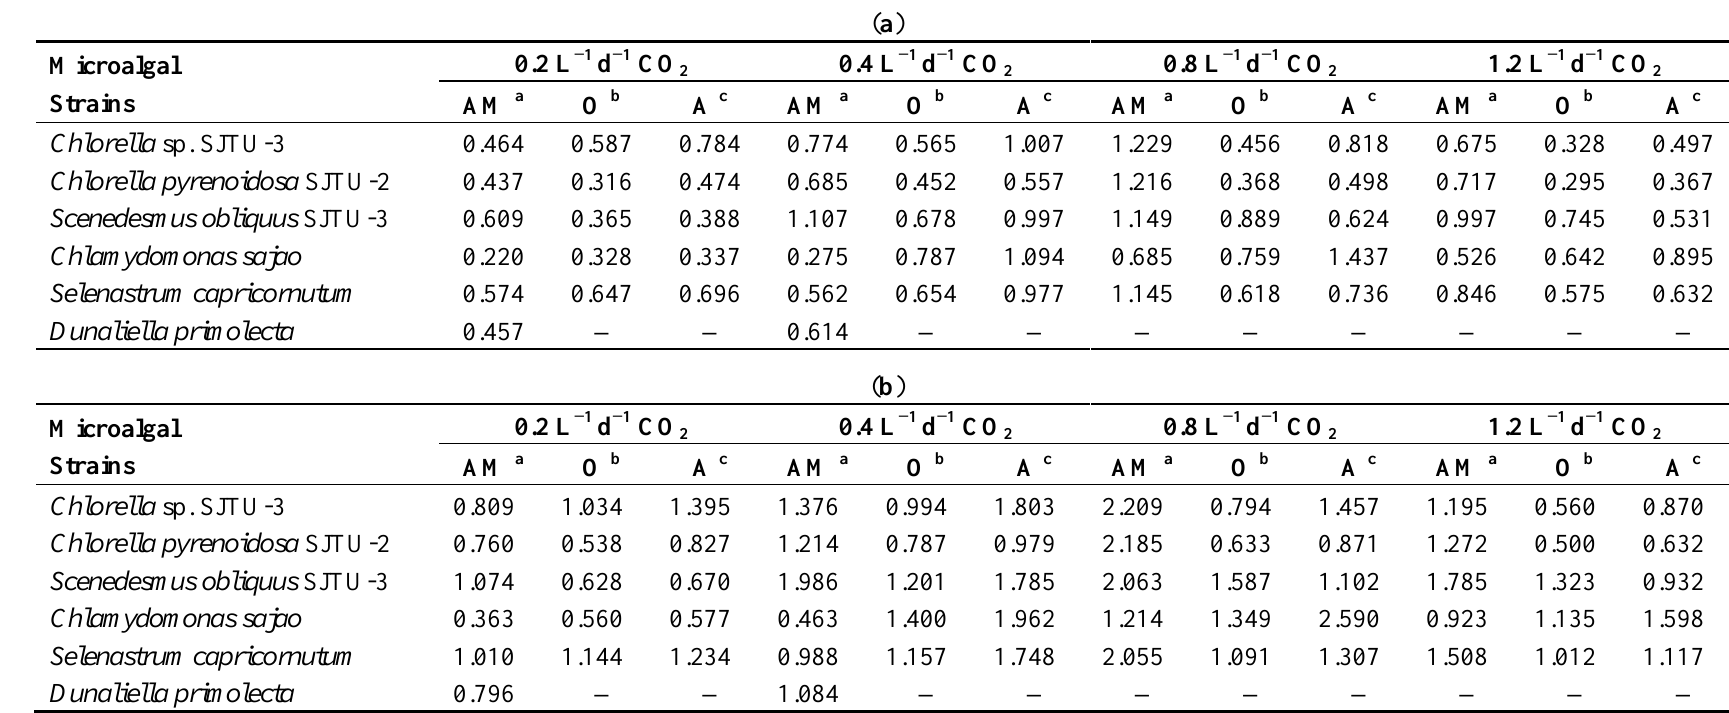
supply conditions after 6 days cultivation 2